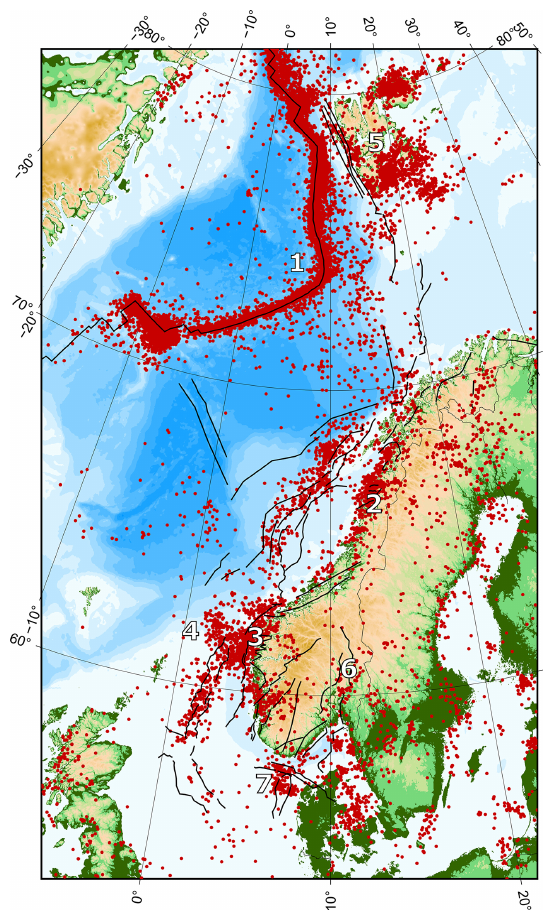
Figure 1. Earthquakes with M ≥ 2.0 recorded by the NNSN in the period 1980–2021CE. Black lines are significant faults as mapped by Smirnova (2019). Numbers mark the most seismically active ar- eas: 1: the northern mid-Atlantic ridge, 2: Nordland, 3: northwest- ern Norway, 4: the North Sea, 5: Svalbard, 6: the Oslo graben and 7: